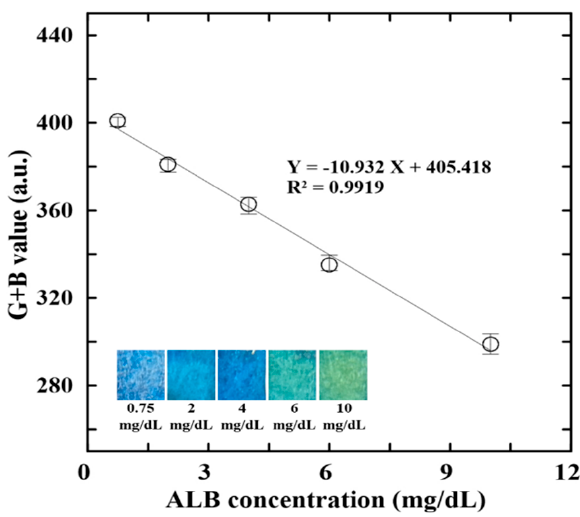
Figure 5. Variation of G + B intensity value with ALB concentration.